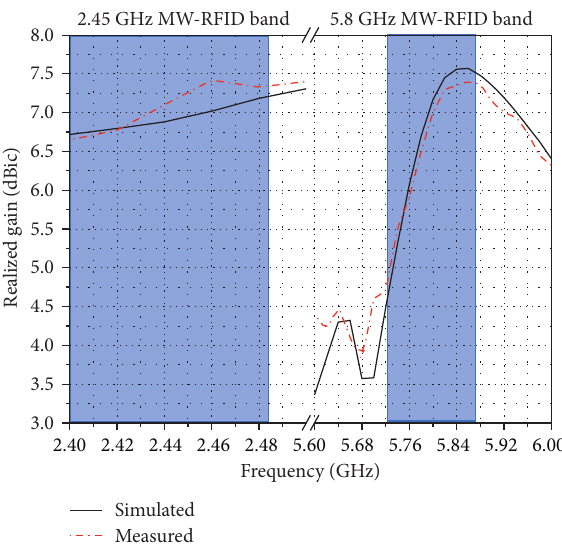
2.45 GHz MW-RFID band